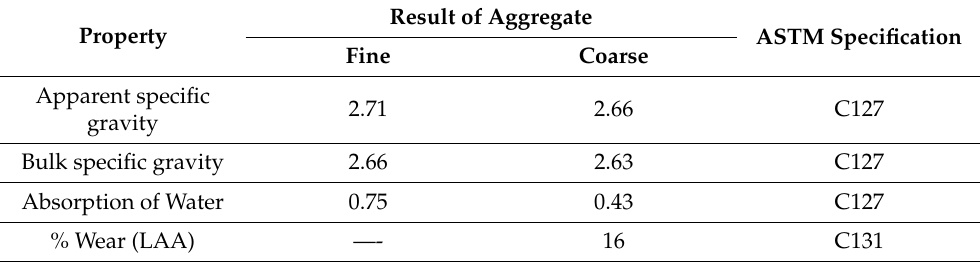
Table 2. Physical properties of aggregate.